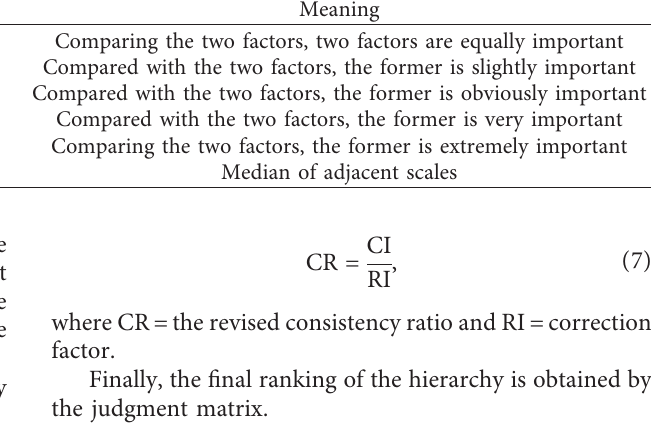
Figure 3: Pull-out test of the composite bridge deck structure. (a) Pull-out test in this paper. (b) The diagram of the pull-out test. Table 5: Definition of the judgment matrix scale.